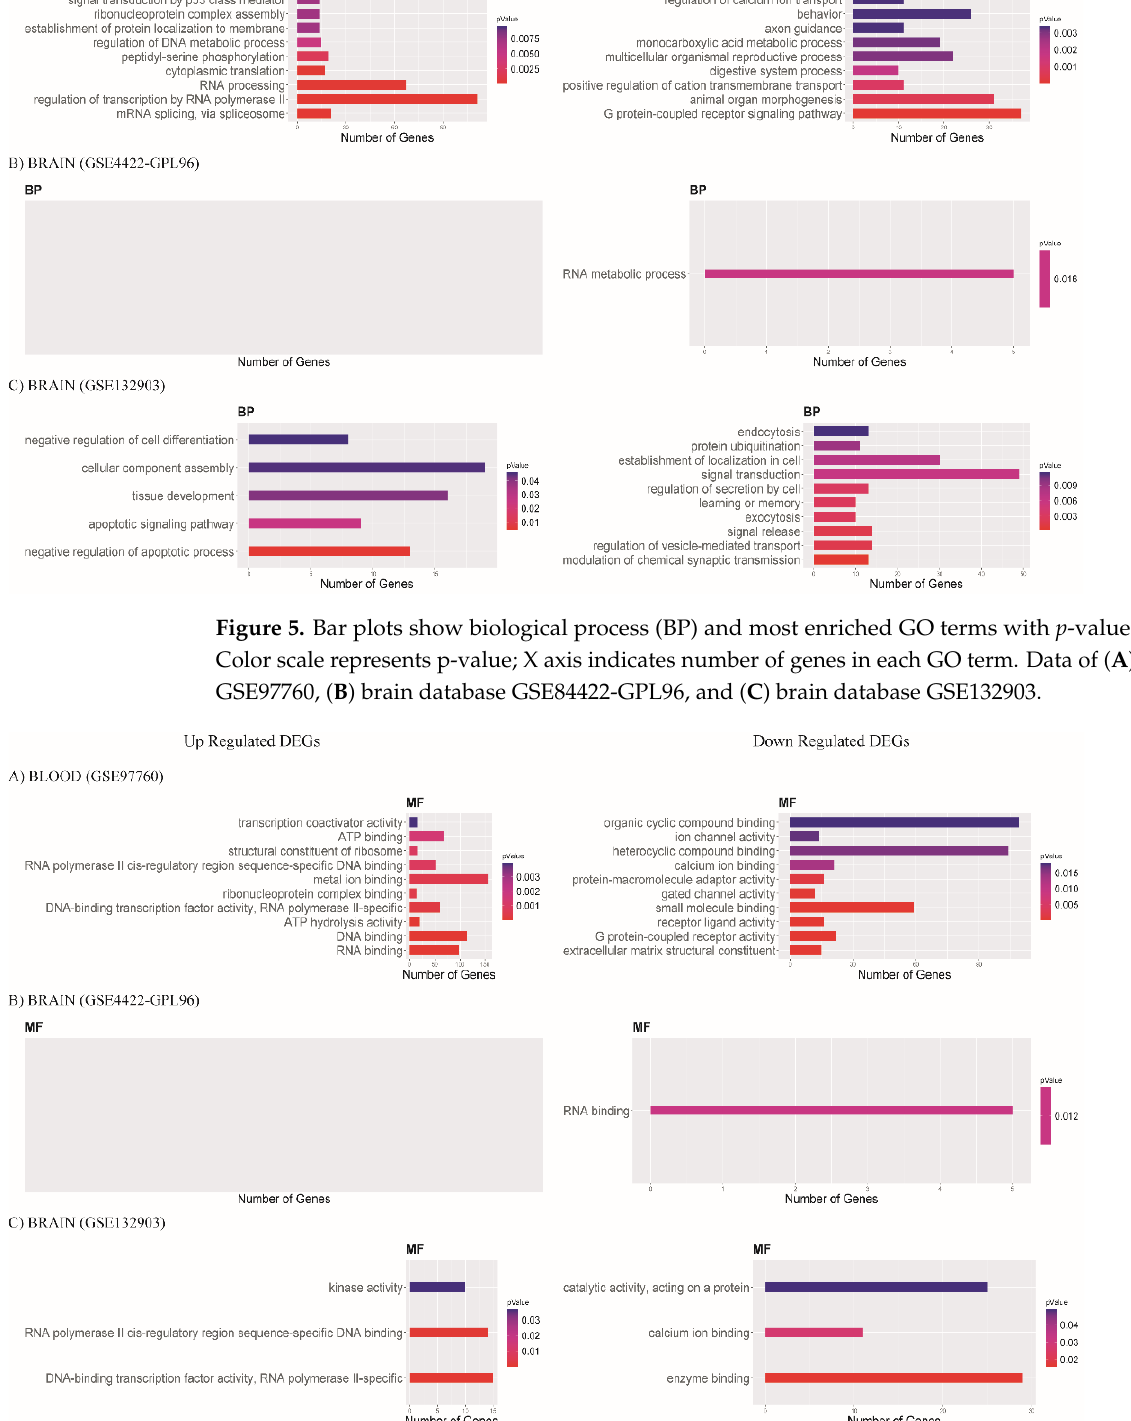
Figure 6. Bar plots show molecular functions (MFs); most enriched GO terms with p- value < 0.05. Color scale represents p-value; X axis shows the number of genes in each GO term. Data of ( A ) blood database GSE97760, ( B ) brain database GSE84422-GPL96, and ( C ) brain database GSE132903.